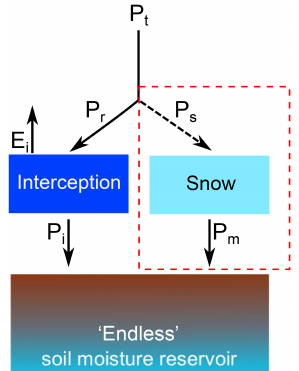
Figure 2. Schematisation of the method to calculate S r , including snow module; the part in the red square is added for this research, the “endless” soil moisture reservoir is similar to the one in de Boer- Euser et al. (2016). The arrow for P s is dashed as this flux is not actually calculated, but P m is derived from the change in S SWE